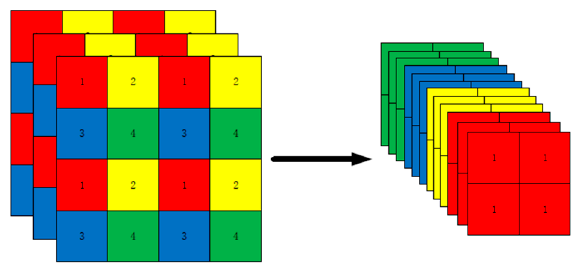
Figure 2. Image slicing by the Focus